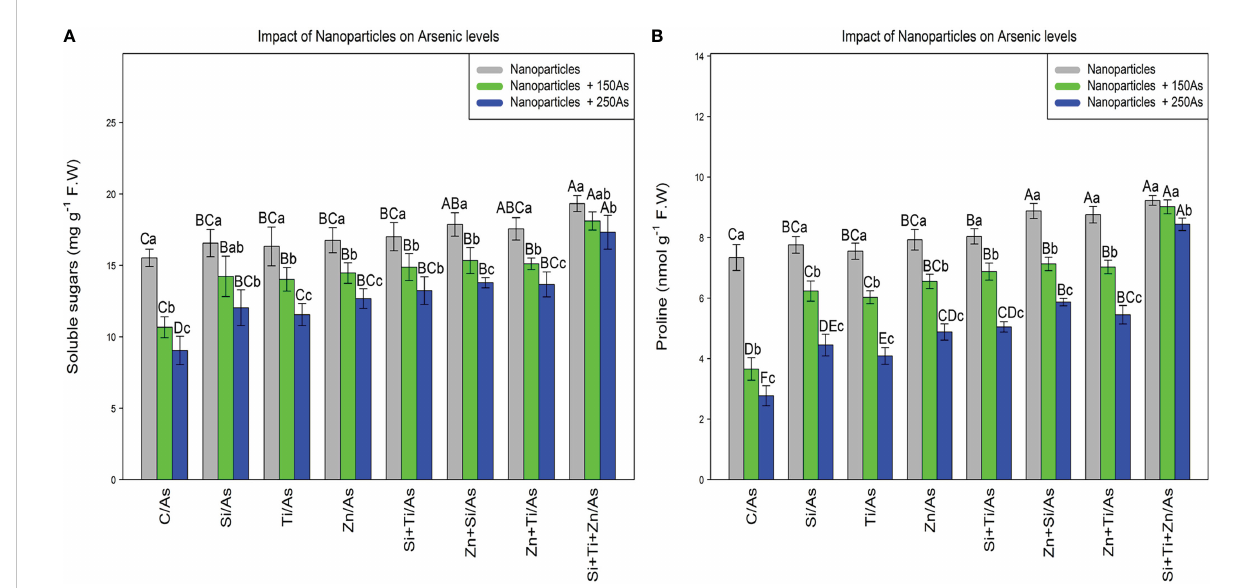
FIGURE 2 The impact of NPs alone and in combination on the concentration of soluble sugars (A) , and proline (B) in one-year-old Pleioblastus pygmaeus exposed to 150 and 250 µM As (four replicates). In this fi gure, the letters a, b, c, etc. indicated signi fi cant differences following the application of NPs with 150 and 250 µM As based on Tukey ′ s test (p<